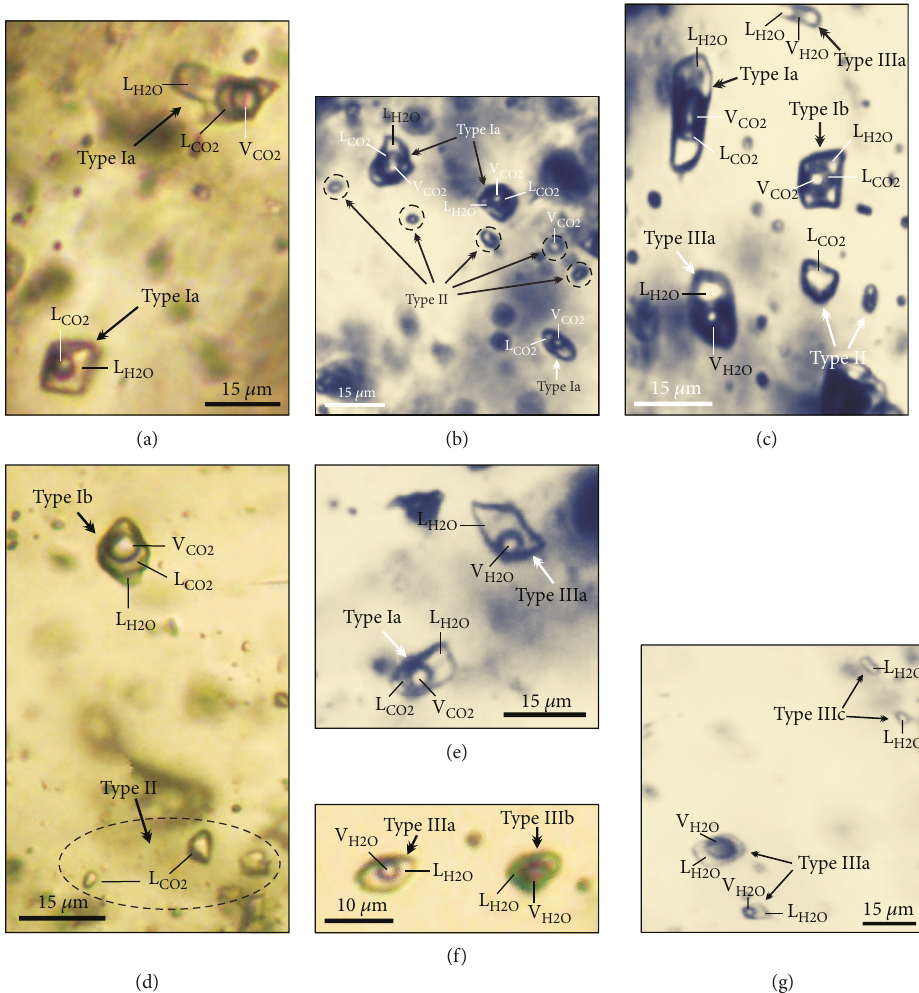
Figure 8: Photomicrographs of fl uid inclusion assemblages from di ff erent hydrothermal stages in the Xiejiagou gold deposit. (a) Primary type Ι a FIs in early-stage quartz; (b) type Ι a FIs coexist with type ΙΙ FIs in early-stage quartz; (c) type Ι FIs coexist with type ΙΙ and type ΙΙΙ a FIs in middle-stage quartz; (d) type Ι b FIs coexist with type ΙΙ FIs in middle-stage quartz; (e) type Ι a FIs coexist with type ΙΙΙ a FIs in middle-stage quartz; (f) primary type ΙΙΙ a and ΙΙΙ b FIs in middle-stage quartz; (g) type ΙΙΙ a and ΙΙΙ c FIs in late-stage